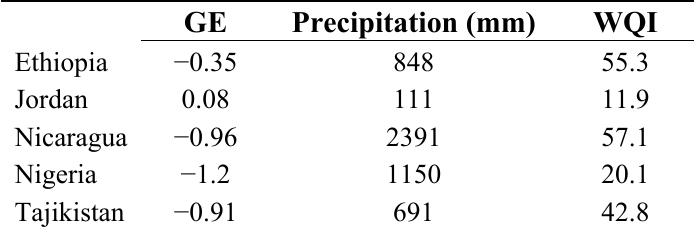
Table 5. Spread of countries on dominant PCA Covariates.